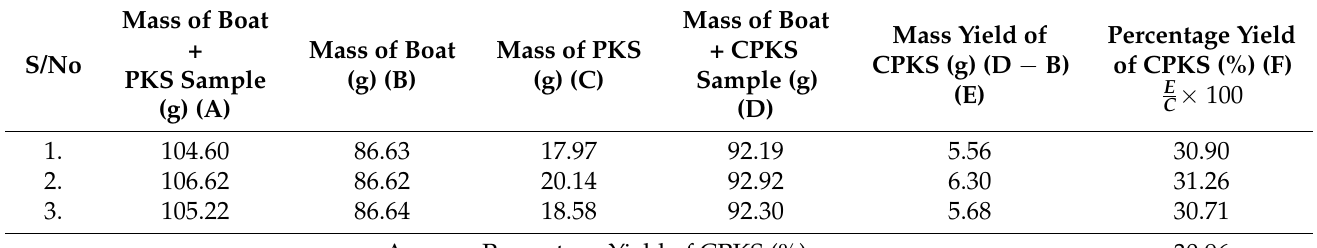
Table 1. Results of percentage yield of the carbonized palm kernel shell